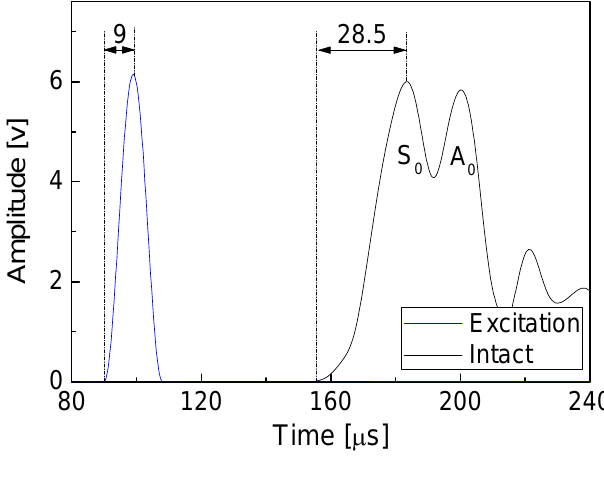
Figure 9. Envelopes of the excitation wave and the guided wave signal captured from the intact CFRP